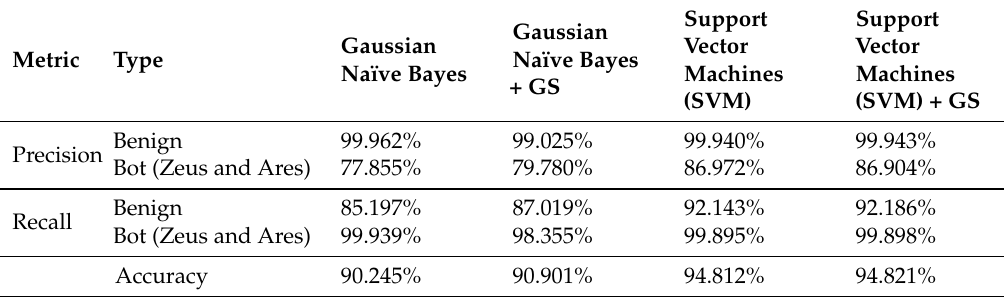
Table 4. Comparative analysis of ML models on the CIC-AWS-2018 dataset filtered by TCP (B).